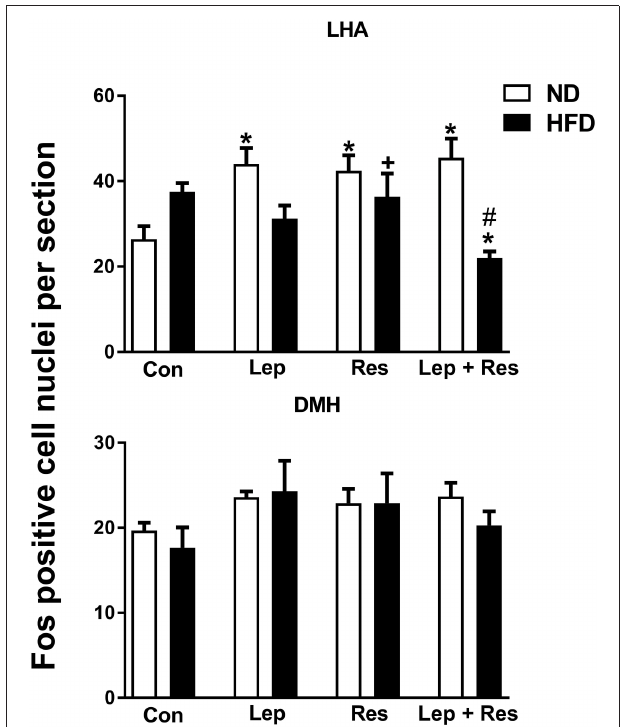
FIGURE 3 | Upper: Numbers of Fos-positive cell nuclei counted unilaterally per section in the lateral hypothalamic area (LHA) from rats fed a normal chow (ND) and a high fat diet (HFD) administered intracerebroventricular (ICV) saline (control, n = 4 ND, n = 4 HFD; 5 µ l), leptin ( n = 4 ND, n = 5 HFD; 7 µ g in 5 µ l), resistin ( n = 4 ND, n = 4 HFD; 7 µ g in 5 µ l), or leptin combined with resistin ( n = 5 ND, n = 6 HFD). * P < 0.05 compared with control. # P < 0.0005 HFD compared to ND. + P < 0.05 hormone alone compared with leptin + resistin. Lower: Numbers of Fos-positive cell nuclei counted unilaterally per section in the the dorsomedial hypothalamic nuclei (DMH) administered ICV saline (control, n = 6 ND, n = 4 HFD; 5 µ l), leptin ( n = 5 ND, n = 5 HFD; 7 µ g in 5 µ l), resistin ( n = 4 ND, n = 4 HFD; 7 µ g in 5 µ l) or leptin combined with resistin ( n = 5 ND, n = 6 HFD).